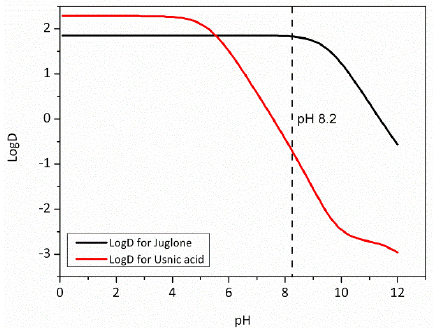
Figure 8. Log D values for juglone and usnic acid, where the vertical dashed line signifies the average sea water pH